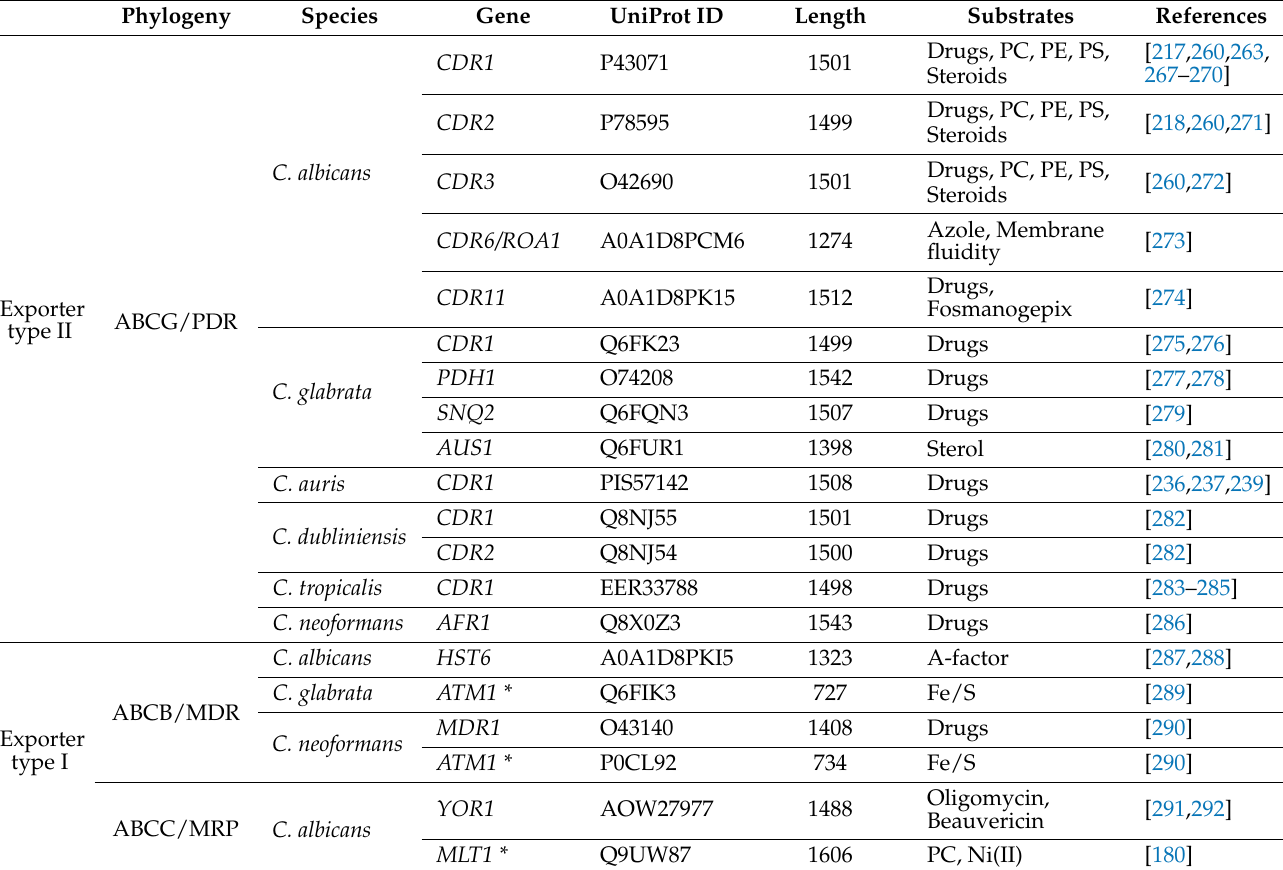
Table 2. ABC efflux transporters mediating MDR in pathogenic fungi. Phylogeny Species